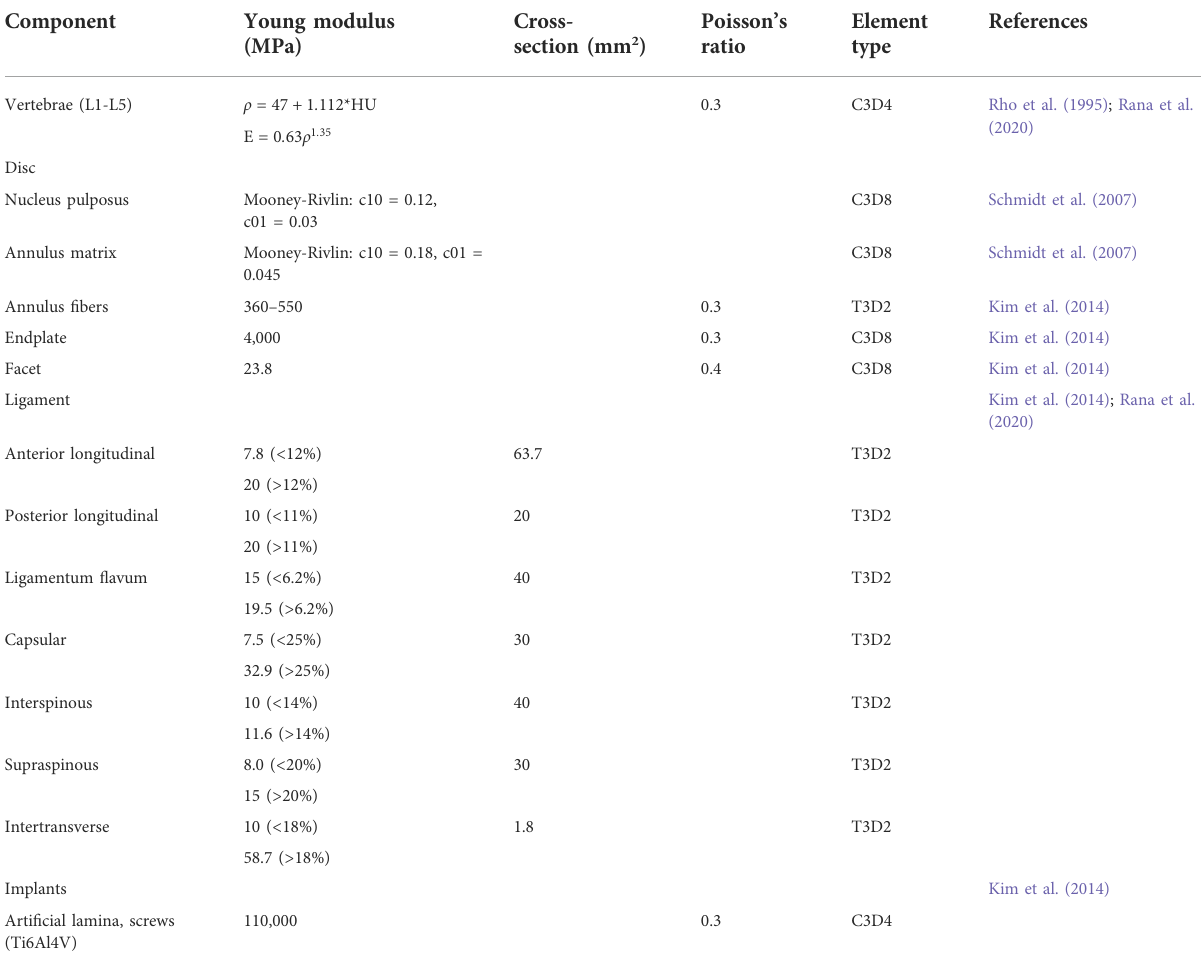
TABLE 1 Material properties of the